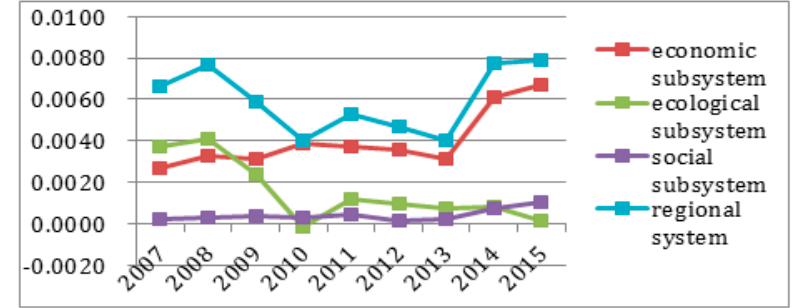
Figure 12. Evaluation value change in the regional sustainable development capacity.